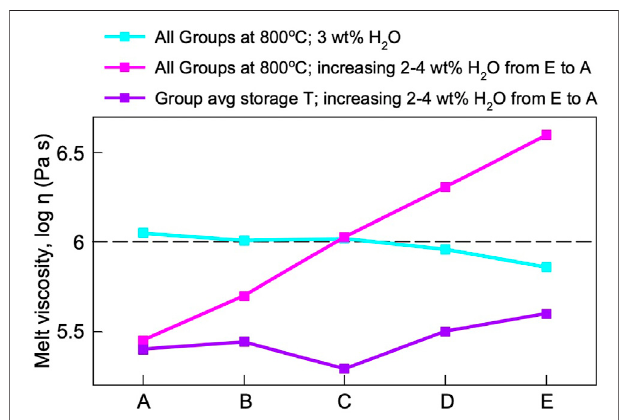
FIGURE 12 | Melt viscosity modeling at various temperatures and water contents for Rattlesnake Tuff (RST) high-silica rhyolites (HSRs) and the viscosity calculator by Giordano et al. (2008). Viscosities calculated using Group average storage temperatures and decreasing water content from 4-2wt% H 2 O from Group A to Group E are interpreted as the most accurate viscosity estimates. The dashed line represents 10 6 Pascals, which istheestimated limitofviscositiesforlarge-volume,high-temperature, crystal- poor rhyolites to experience uninhibited crystal-melt segregation in the process of fractional